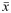
Serum levels of anti-Sm antibodies at 7 and 12 weeks.Data are shown in x¯ ± SE. Differences between groups unpaired Mann Whitney U test, P < 0.05. A) Anti-Sm antibodies serum levels at 7 weeks. B) Anti-Sm antibodies serum levels at 12 weeks.